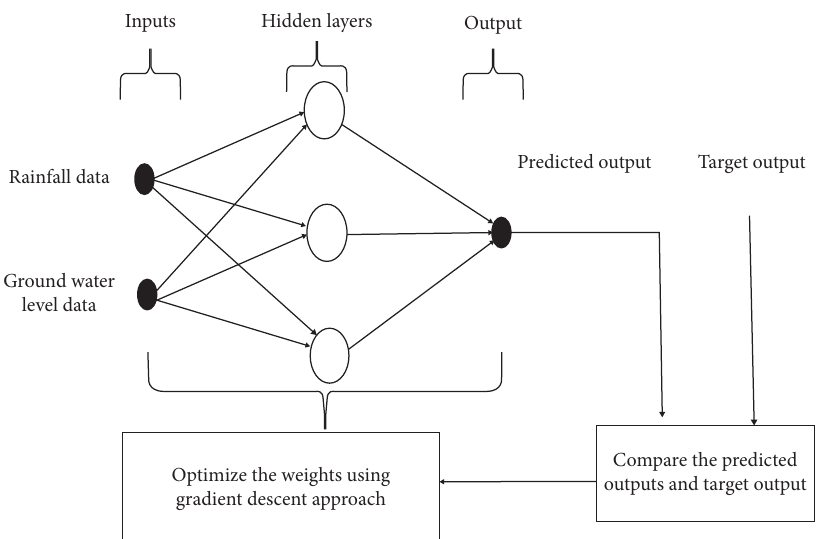
Figure 2: The FFNN weight optimization using the gradient descent